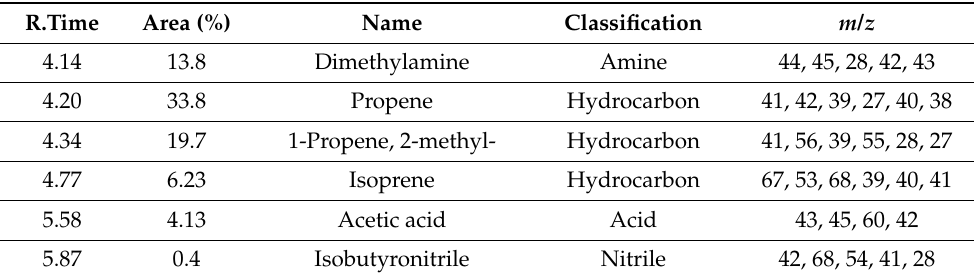
Figure 9. Py-GC/MS chromatogram for analyzed sample. Inset: Signal close-up to clarify thermal products in less than 10 min of retention times. Table 3. Py-GC/MS detected